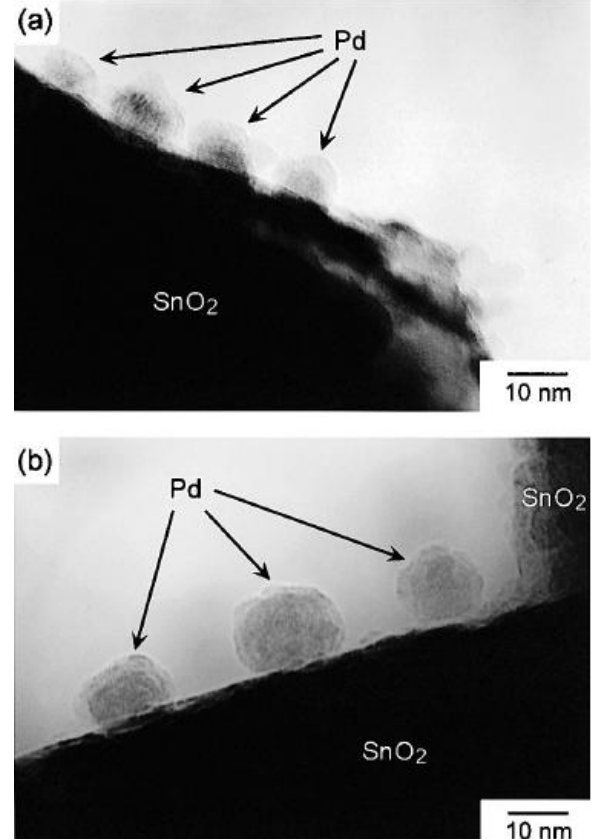
Figure 5. Two representative TEM photographs of Pd particles loaded on the surface of SnO2 (adapted from